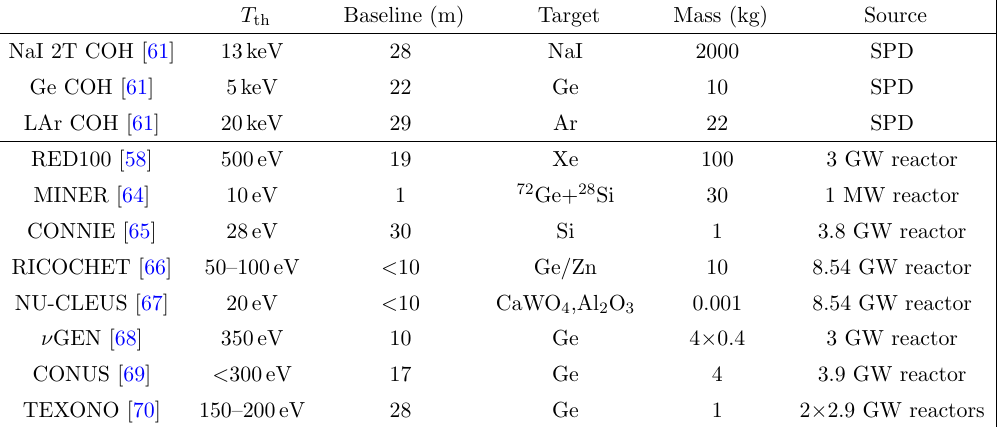
Table 4 . A list of proposed experiments to detect CE (cid:23) NS using (anti)neutrinos from Stopped Pion Decay (SPD) or from reactors, with recoil energy threshold, T th , the distance from the source, the target material and its mass given in 2nd to 4th